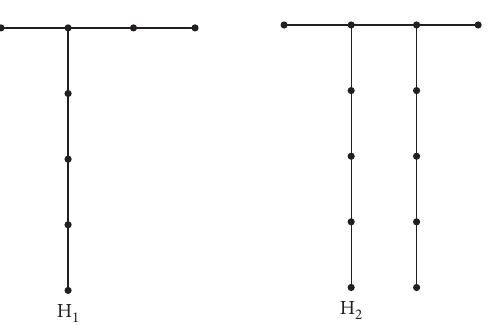
Figure 3: The two exceptional trees H